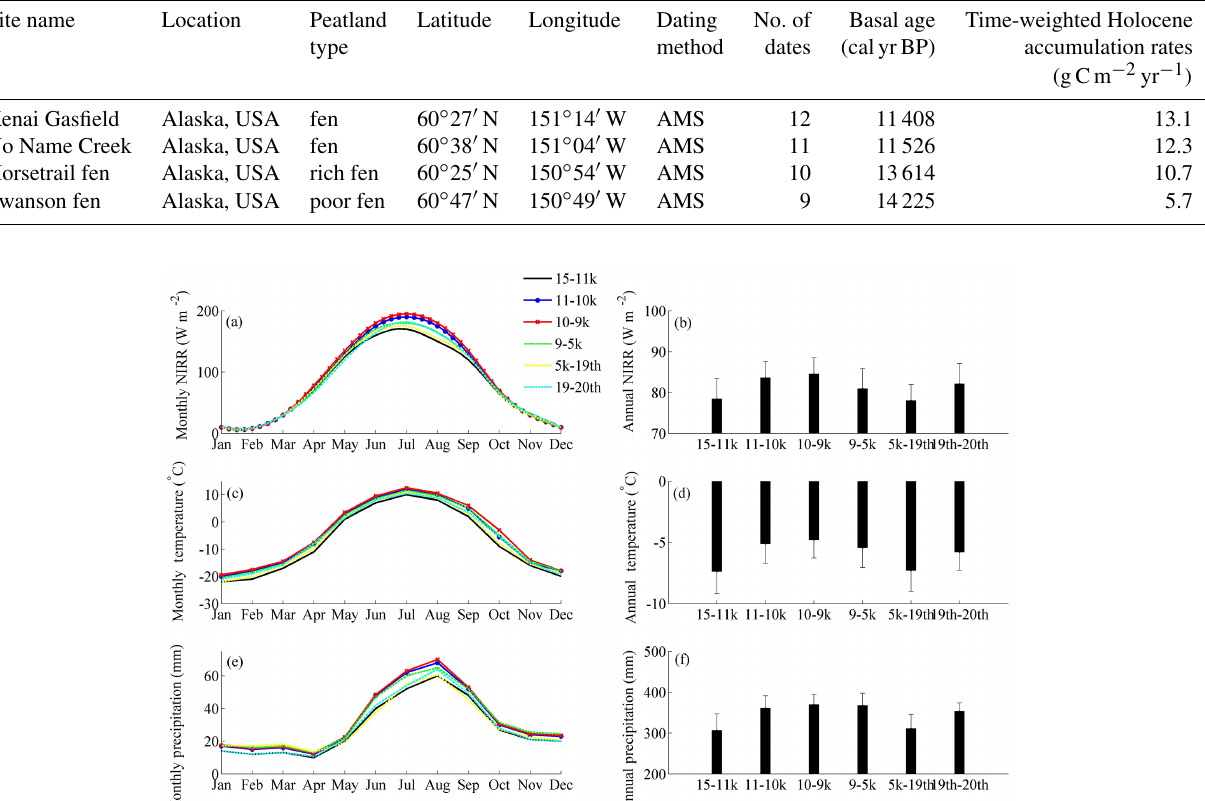
Figure 3. Simulated paleo-climate and other input data from 15ka to 2000AD: (a) mean monthly and (b) mean annual net incoming solar radiation (NIRR, Wm − 2 ) , (c) mean monthly and (d) mean annual air temperature ( ◦ ), and (e) mean monthly and (f) mean annual precipitation (mm) (Timm and Timmermann, 2007; He et al.,